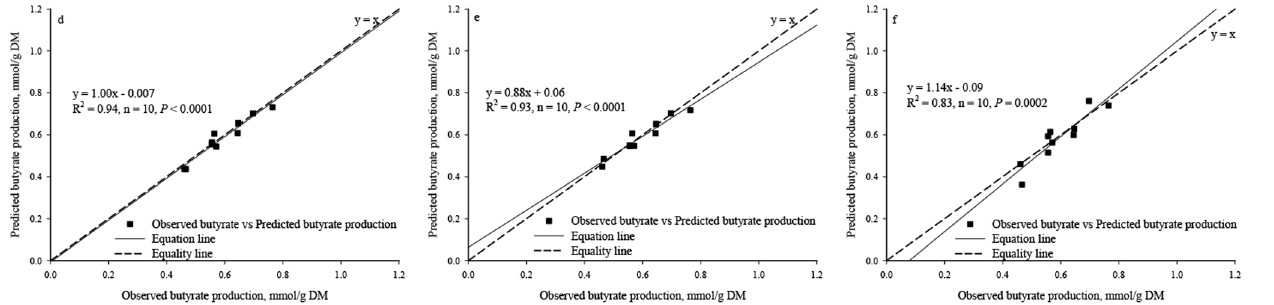
Fig. 4. Relationship between the observed vs. the predicted butyrate production. ( d . Predicted values were from Equation II; e . Predicted values were from BP3 model where butyrate production using as individual output; f . Predicted values were from BP3 model where butyrate production was output simultaneously.)